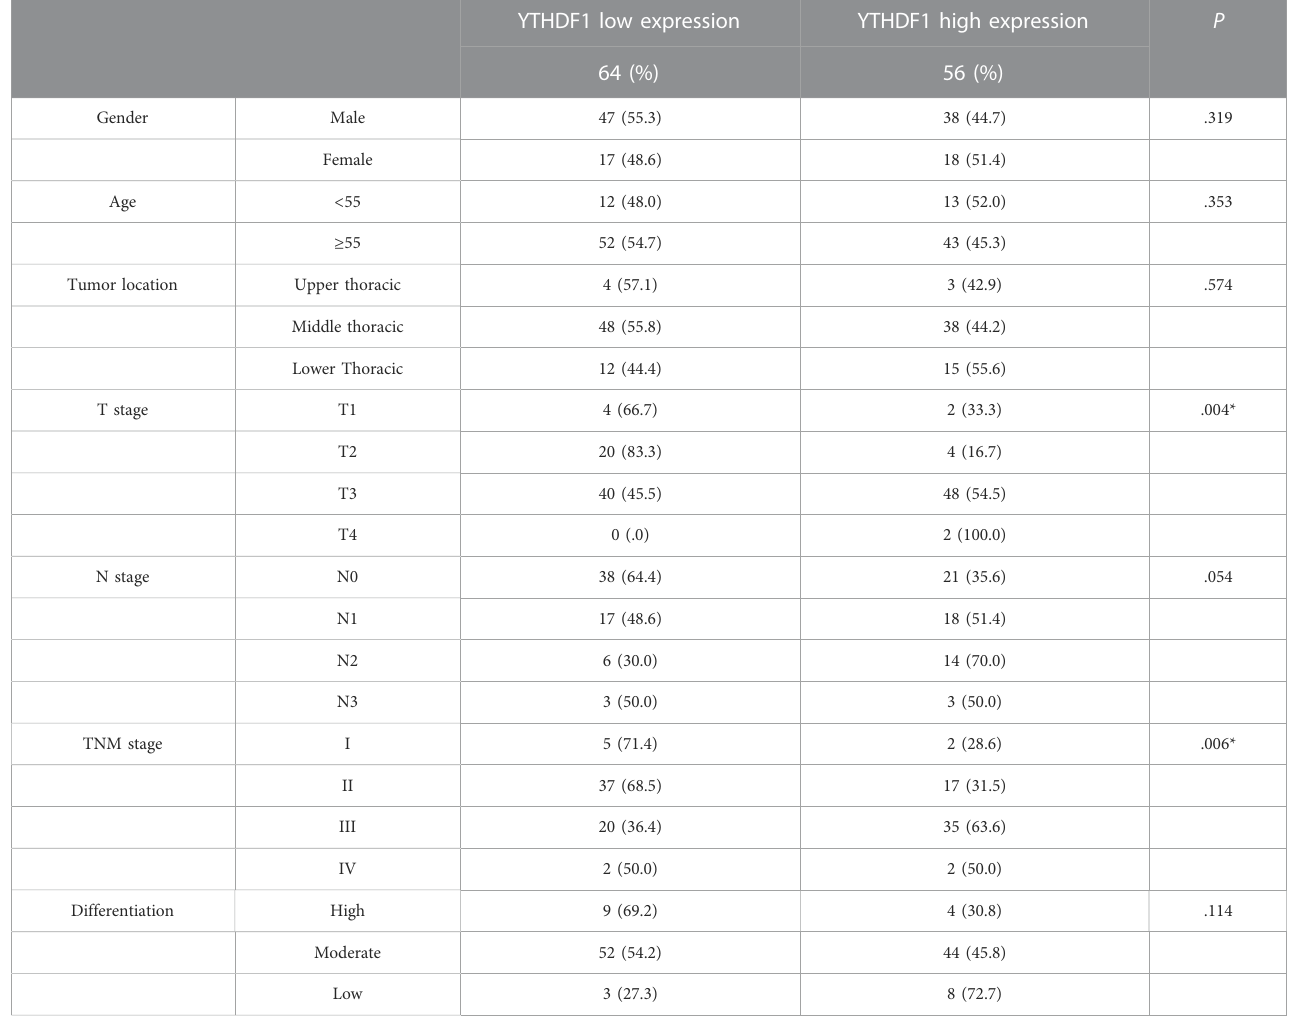
TABLE 1 Clinicopathological characteristics of YTHDF1 expression on ESCC tissue